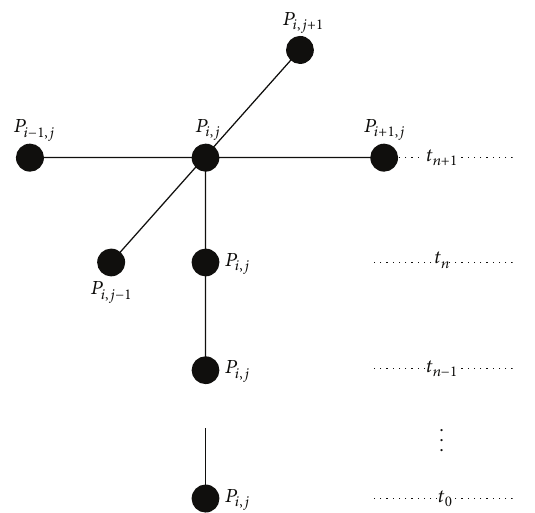
Figure 1: The data dependence of 2D-TFDE of grid point 𝑃 𝑖,𝑗 of time step 𝑡 𝑛+1 .